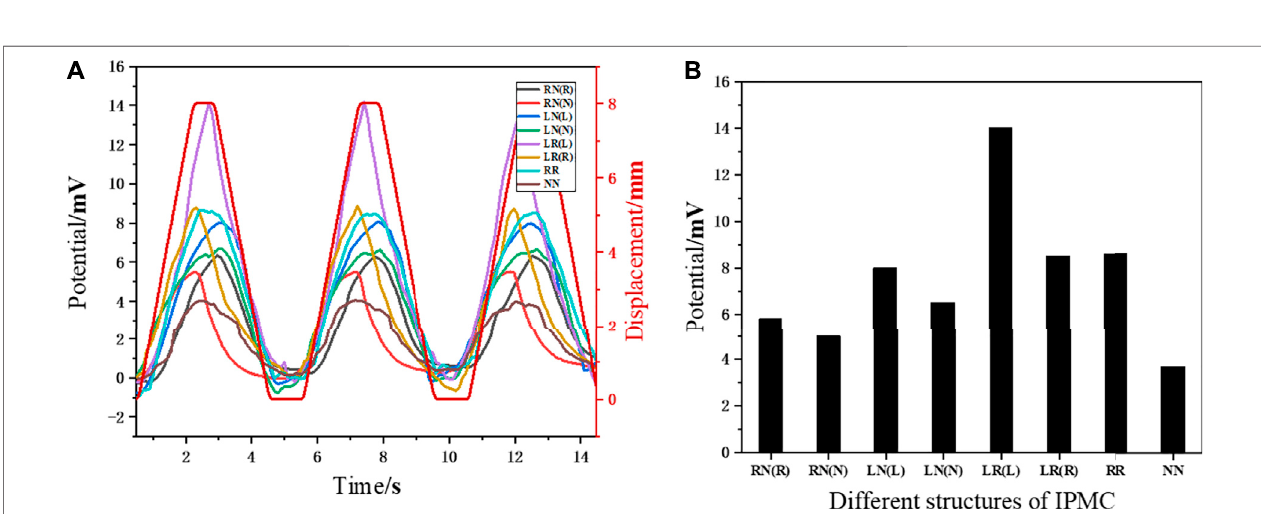
Frontiers in Materials |